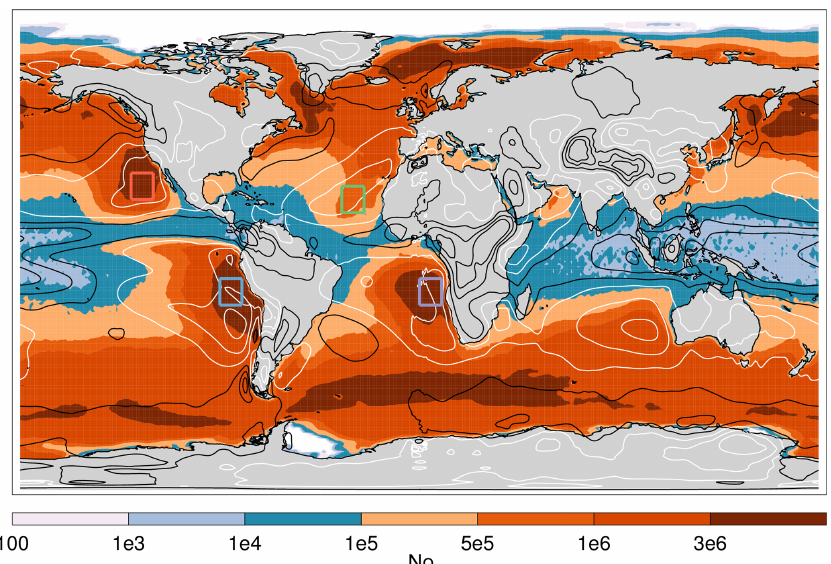
Figure 6. Number of observations found in the AMSR–MODIS dataset over 2002 to 2017. Overlaid contours display air vertical velocity at 500hPa ( ω 500 ) from ERA-Interim, with white contours at 0.01, 0.03, and 0.05Pas − 1 denoting sinking of air and black contours − 0 . 05, − 0 . 03, and − 0 . 01Pas − 1 denoting rising of air. A 2-D smoothing has been applied to the ω 500 fields. Color rectangular boxes identify regions with a high number of stratocumulus clouds. These locations are adopted from Klein and Hartmann (1993).